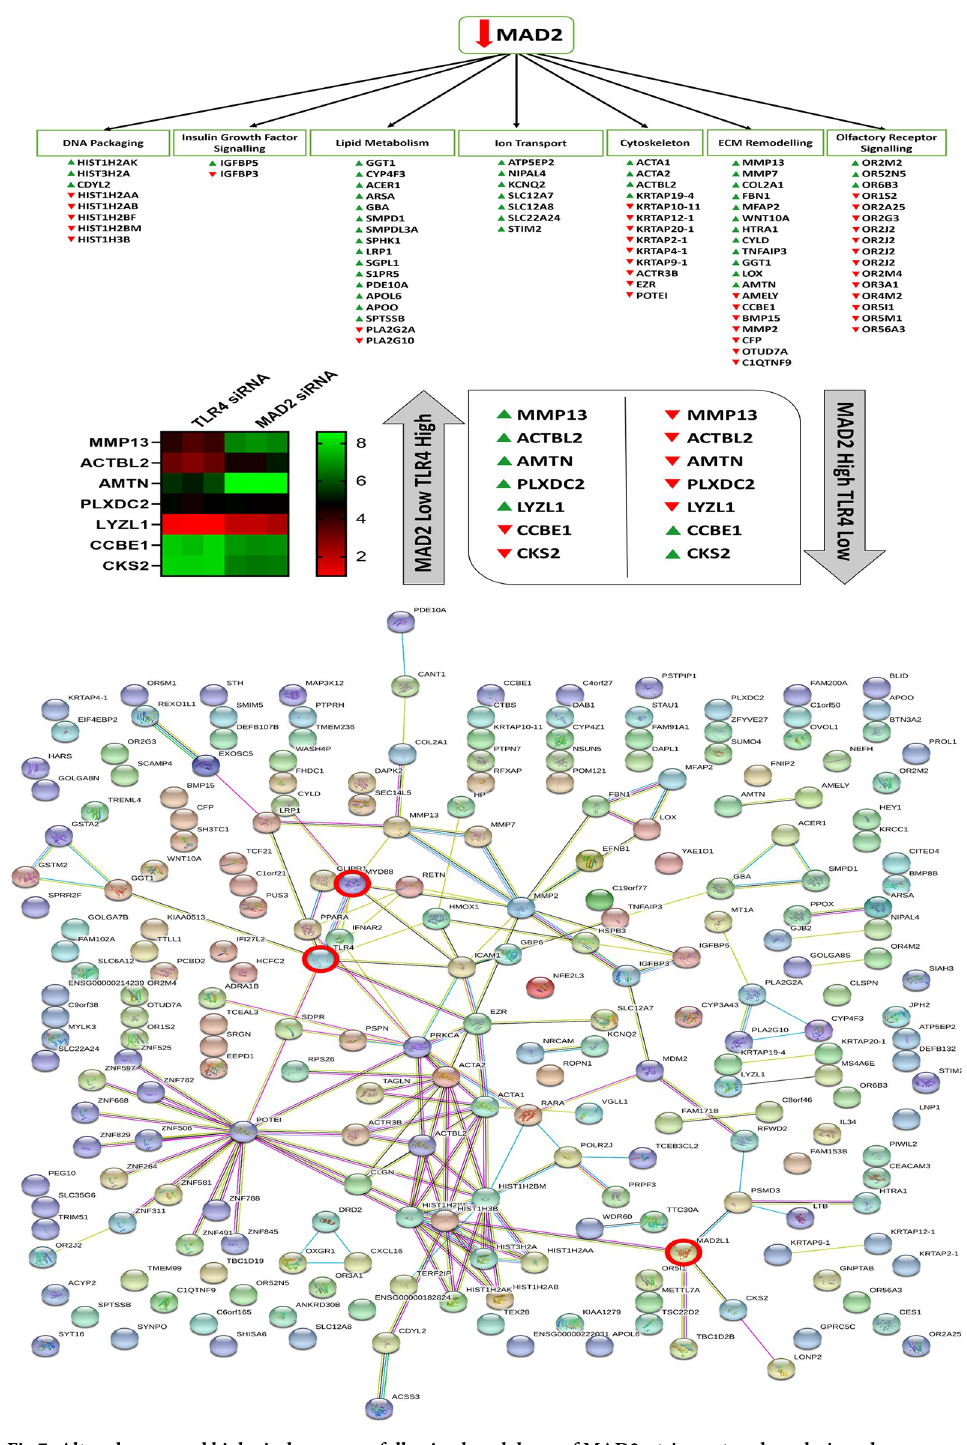
Fig 7. Altered genes and biological processes following knockdown of MAD2, string network analysis and cross comparison of the MAD2 and TLR4 knockdown data sets. Microarray analysis revealed that suppression of MAD2 and the induction of senescence affects various genes involved in DNA packaging, lipid metabolism, ion transport, Insulin-like growth factor signalling, ECM remodelling and olfactory receptor signalling and components of the actin cytoskeleton. Cross comparison of the two microarray data sets identified 7 key genes which are differentially regulated in both data sets. String network analysis plots of each of the altered genes identified in both data sets and how they relate to each other and TLR4, MyD88 and MAD2 which are highlighted by red